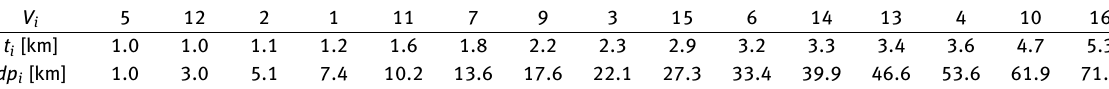
Table 6: Calculation of the dp i parameter based on sorted distances between V 0 and V i for one AGV V i